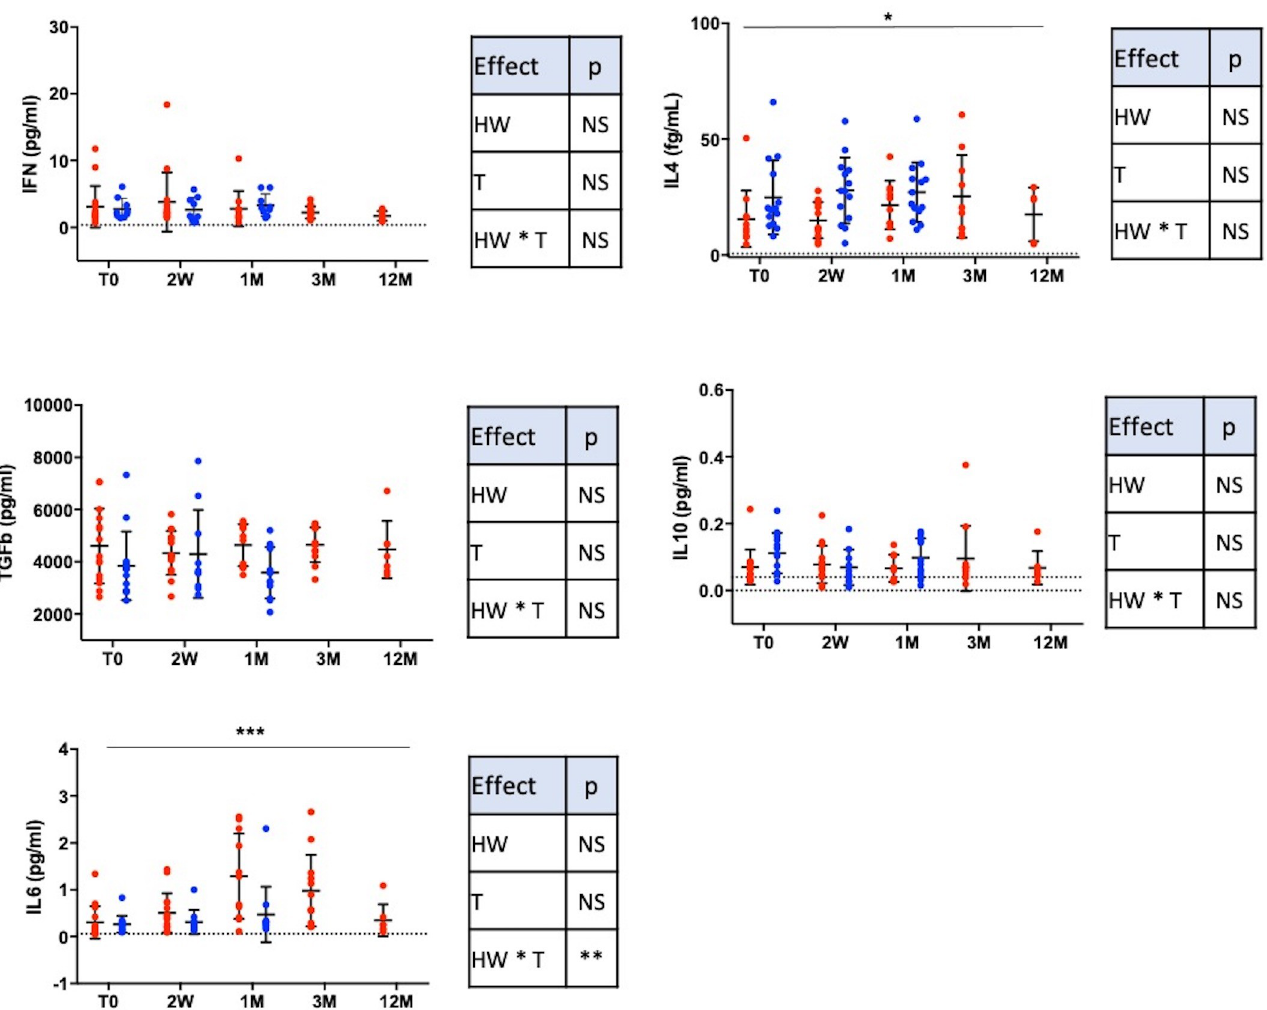
Fig 4. Systemic cytokines. Results are expressed as mean +/- SD. 2W: 2 weeks, 1M: 1 month, 3M: 3 months and 12M: 12 months after treatment. Lower limit of Detection (LoD) is symbolized with dotted line. The HW+ group is represented with red dots and the HW- group with blue dots. To compare the HW+ and HW- groups and their evolution, a maximum likelihood analysis has been used to test a group (HW), a time (T) and a group � time (HW � T) interaction effects (with data at T0, 2W and 1M). Statistical results are summarized in correspondent tables for each parameter. To compare longitudinal data from the HW + group (T0, 2W, 1M, 3M and 12M), a time and a time 2 effects were tested. The time effect is depicted on the figures and the time 2 effect is given in the results section ( � p < 0.05, �� p < 0.01, ��� p <